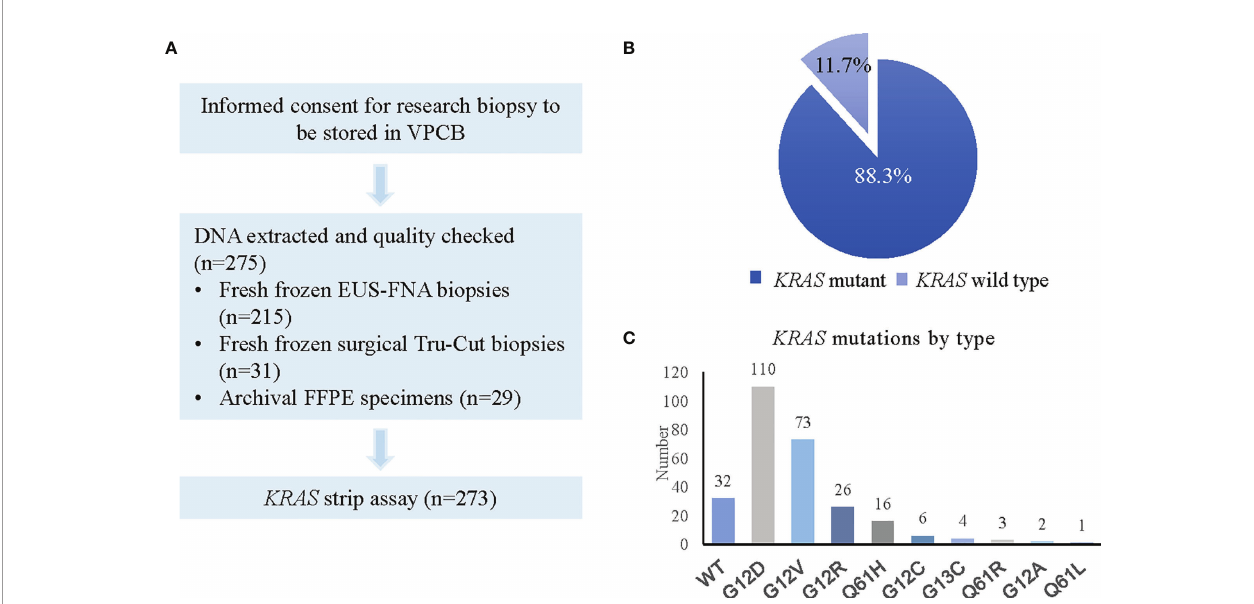
FIGURE 2 | KRAS status screening in PDAC patients. (A) Flow chart showing process for KRAS screening. (B) Pie chart representing KRAS positivity rate. (C) Graph depicting types of KRAS mutations